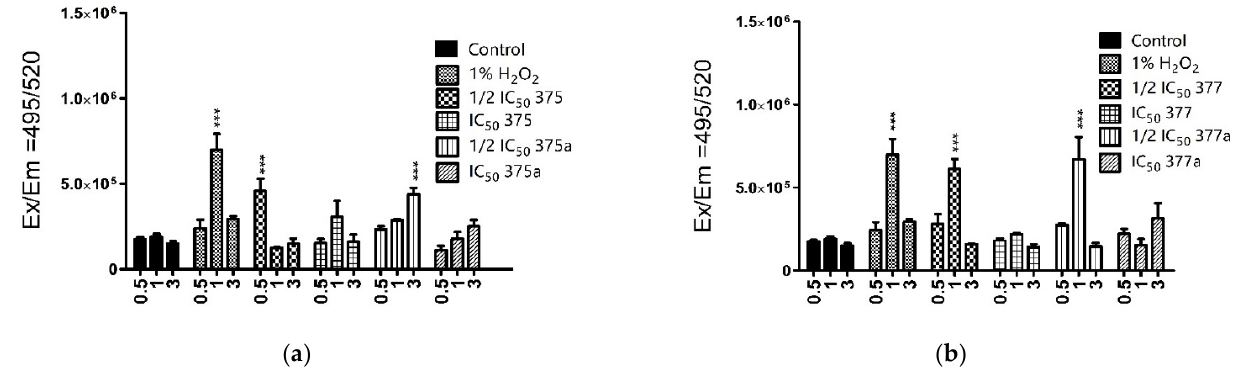
Figure 4. Cytosolic levels of reactive oxygen species in HEC-1A cells after 0.5, 1 and 3 h-treatment with 375 (rhenium aspirin), 375a (aspirin) ( a ), 377 (rhenium indomethacin) and 377a (indomethacin) ( b ). Cells were preincubated with H2DCF-DA dye and then treated with the tested drugs. Data were obtained by measuring the fluorescence at Ex/Em = 495/520 nm. 1% H 2 O 2 was used as a positive control. Results were statistically compared with the negative control (untreated cells with 1% DMSO dissolved in cell culture medium). Two-way ANOVA with Bonferroni multiple comparison test was used for statistical analyses; *** = p < 0.001.